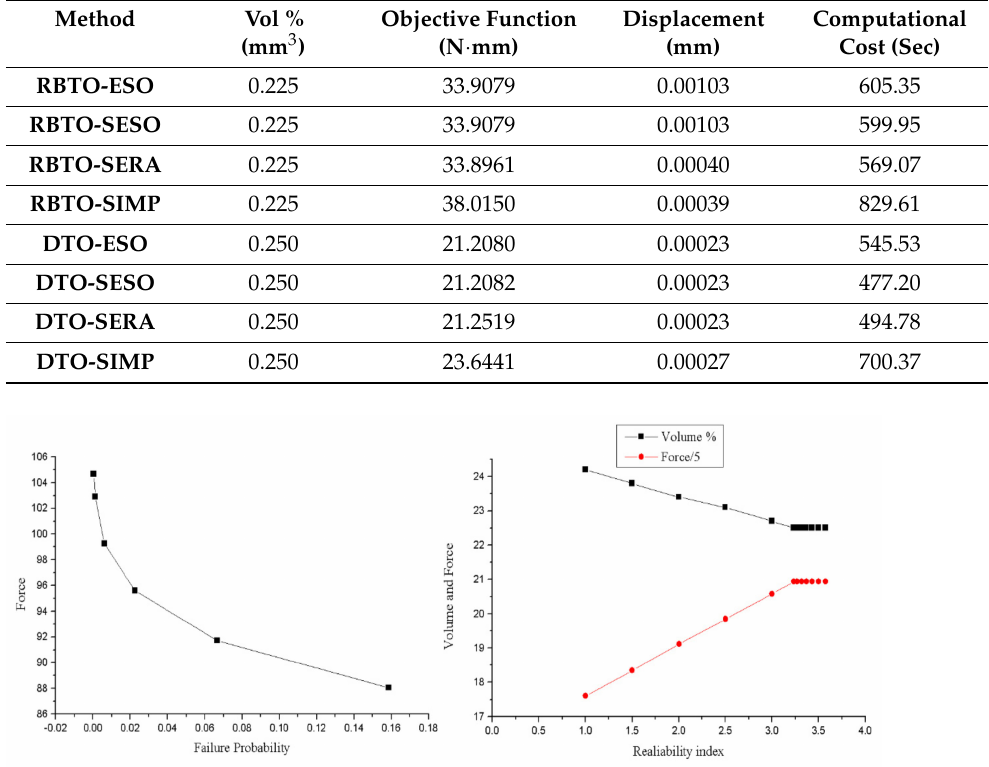
Figure 15. Optimal topologies for DTO and RBTO: ( a ) ESO, ( b ) SERA, ( c ) SESO and ( d ) SIMP. Table 6. Reliability-based topology optimization using evolutionary methods.